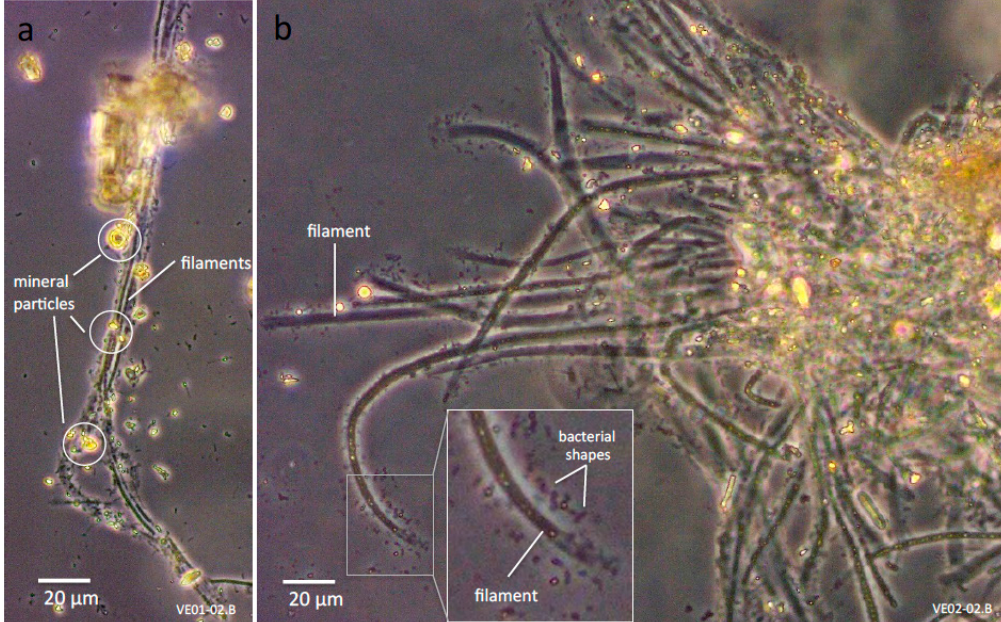
Figure 4. Representative samples depicting filamentous cyanobacterial morphotypes intermixed with calcitic precipitates: ( a ) Sample VE01-02.B; mineral particles attached along cyanobacterial filaments. ( b ) Sample VE02-02.B; multiple bacterial morphotypes (inset) adjacent to a filament.